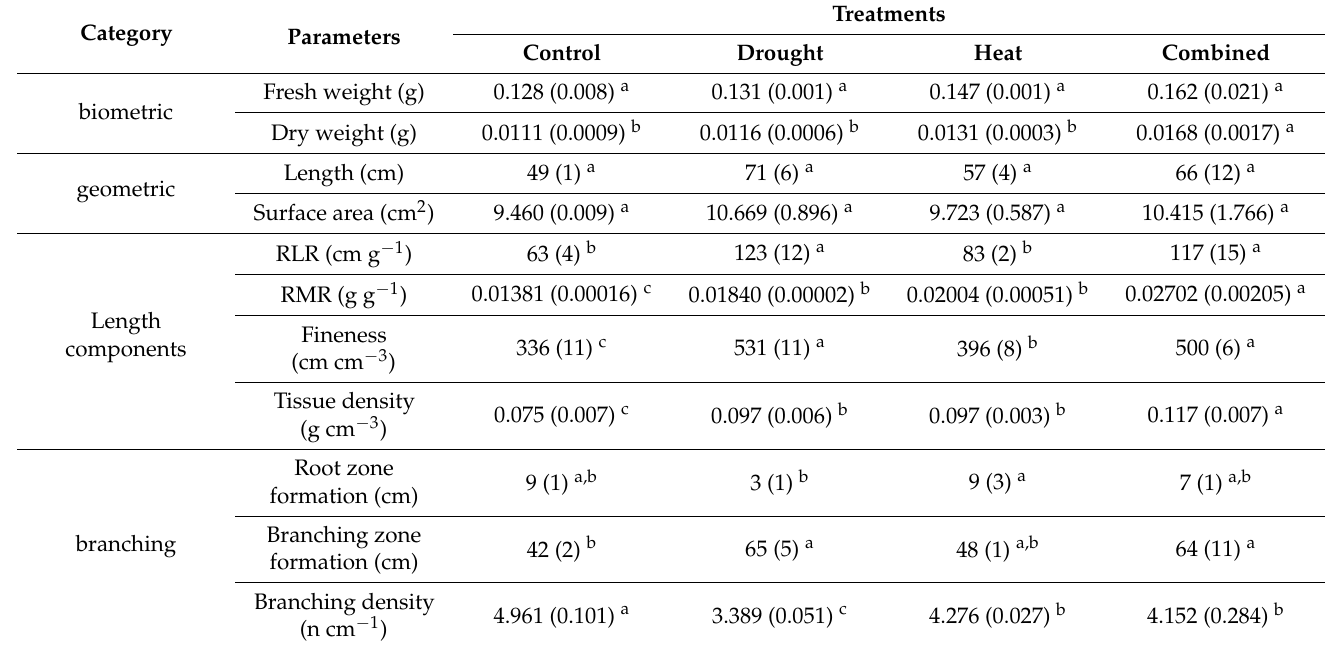
Table 1. Morphology of primary root of maize plants exposed to single (drought and heat) and combined stress (drought + heat).